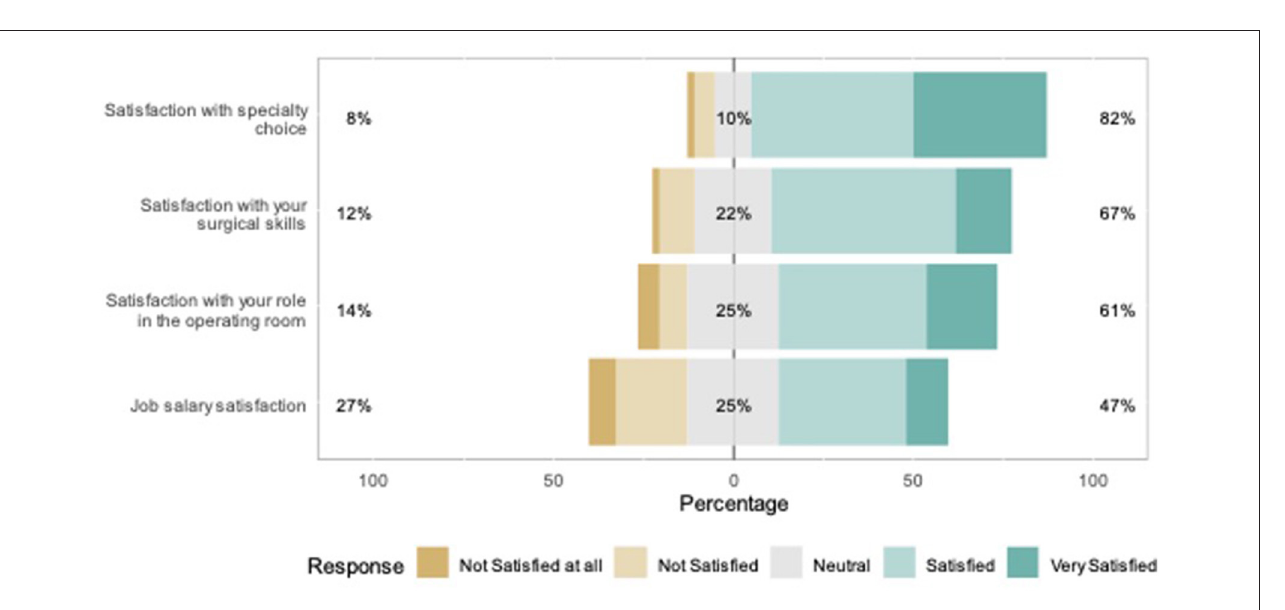
More regular physical exercise was a significant predictor of higher PA scores (B = 5.72, p < 0.05) ( Tables 4 , 5 ). Thus,